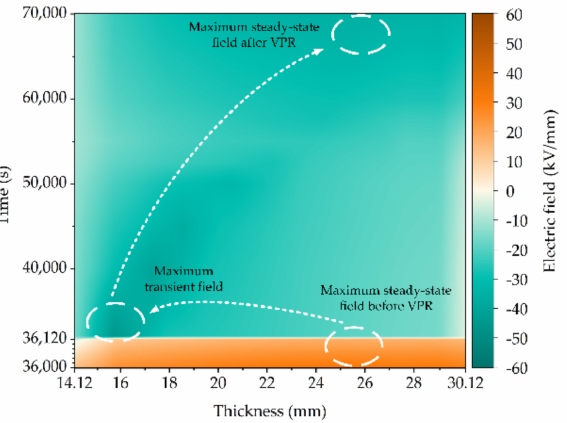
Figure 11. Electric field distribution in the HVDC extruded cable at a load current of 800 A, under the applied DC voltage shown in Figure 3 with a PRP of 120 s.